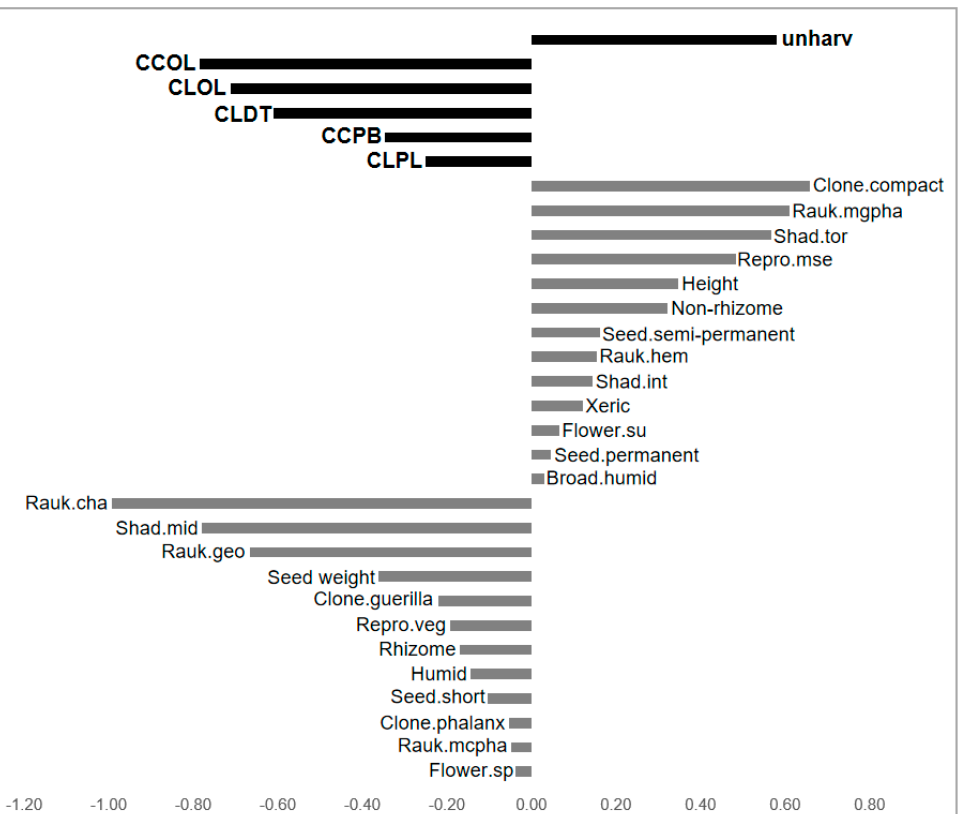
Figure 4. Plot of the eigenvalues along RLQ axis 1 relating different combinations of retention pattern and site preparation (black bars) and functional traits (grey bars). The combination and trait groups with similar positions along the axis co-vary. The different combinations were: CLPL: plowing after careful logging, CLDT: disk trenching after careful logging, CCPB: prescribed burning after clear cut, CLOL: careful logging only, CCOL: clear cut only, and unharv: unharvested. The abbreviations for traits are defined in Table 3.